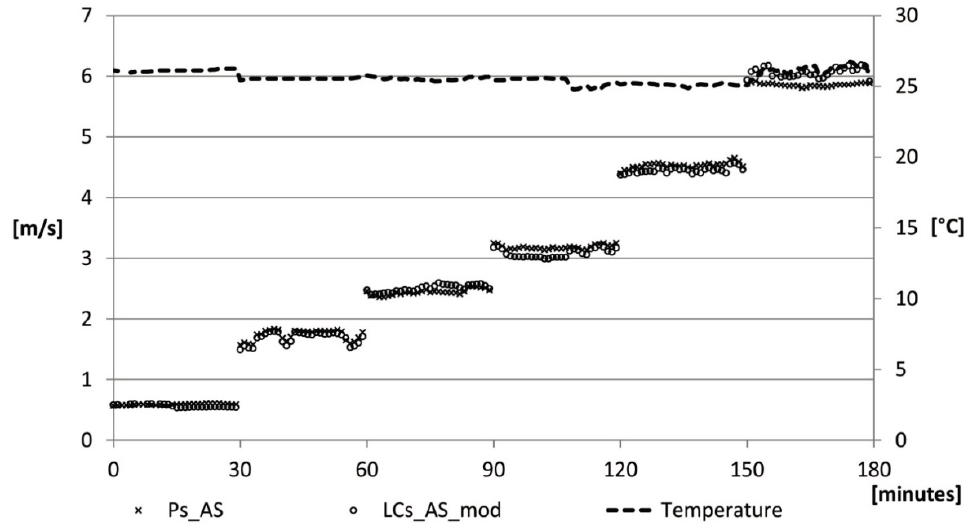
Figure 10. Air speed velocity: correction phase.